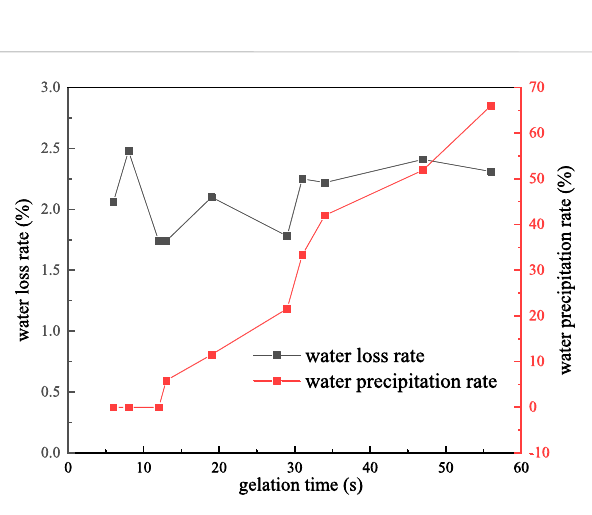
FIGURE 6 Changes in the water loss rate and water precipitation rate of the polymer colloid fi re extinguishing agent with different gelling